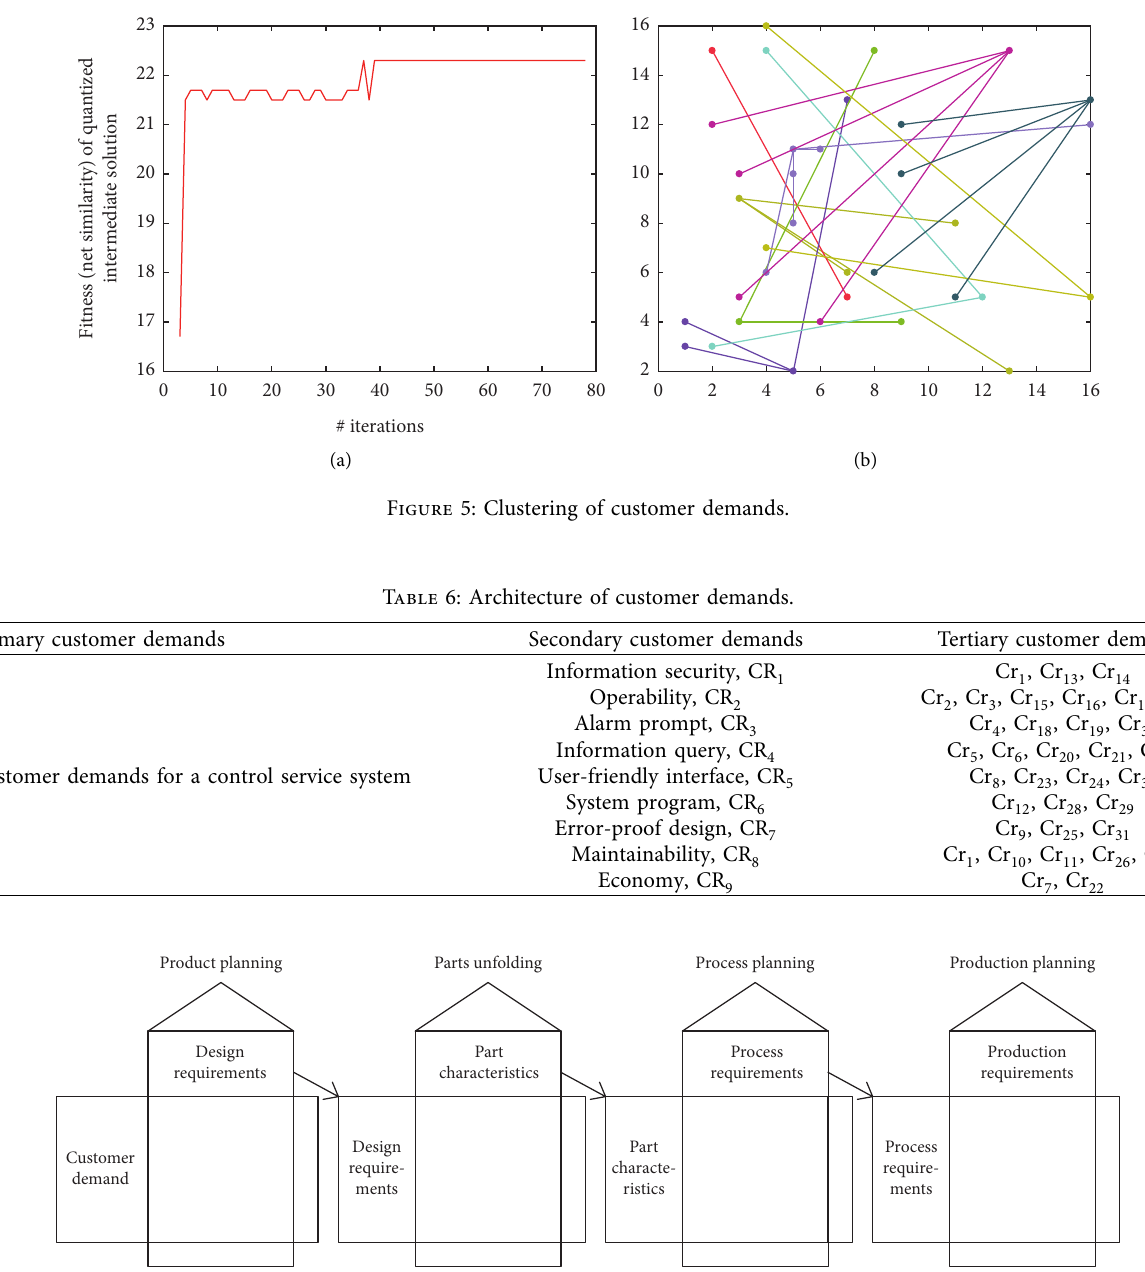
Figure 6: Four stages of QFD configuration. Table 7: Evaluation and decision table for the correlations between the demand and technical characteristics. Symbol Value Meaning 5 Strong correlation between the demand and technical characteristics 3 Medium correlation between the demand and technical characteristics Weak correlation between the demand and technical characteristics